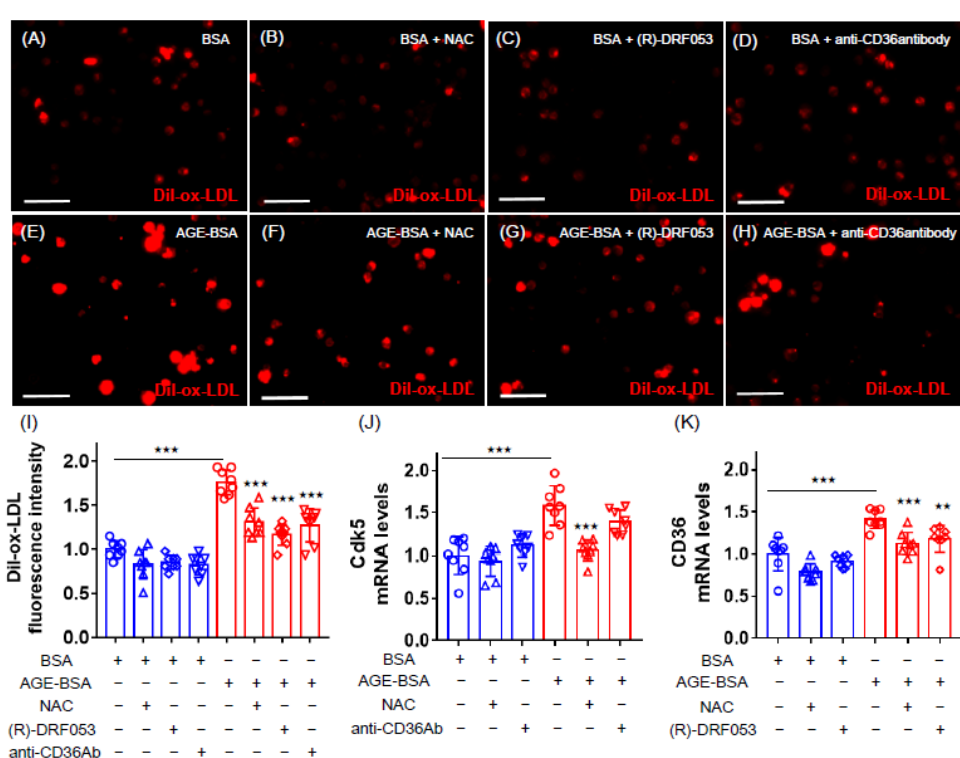
Figure 2. E ff ects of N -acetyl- l -cysteine (NAC), (R)-DRF053 dihydrochloride, and anti-CD36 antibody on Dil-ox-LDL uptake, Cdk5 and CD36 gene expression in AGE-exposed U937 cells. U937 macrophages were treated with 100 µ g / mL AGE-BSA or 100 µ g / mL nonglycated BSA in the presence or absence of 1 mmol / L antioxidant NAC, 0.215 µ mol / L selective inhibitor of Cdk5 (R)-DRF053 dihydrochloride, or 10 µ g / mL anti-CD36 antibody in RPMI 1640 medium supplemented with 10% fetal bovine serum including 100 ug / mL streptomycin and 100 U / mL penicillin at 37 ◦ C in 5% CO 2 for 24 h. The cells then were incubated with 10 µ g / mL Dil-ox-LDL in the same RPMI 1640 medium for 18 h to evaluate the fluorescence intensity. ( A – H ) Representative immunofluorescent staining images. Dil-ox-LDL-positive cells were stained in red. Scale bars represent 50 µ m. ( I ) Quantitative data of fluorescence intensity. Dil-ox-LDL uptake was normalized by the control values with BSA. ( J , K ) Gene expression levels of Cdk5 ( J ) and CD36 ( K ). Total RNAs were transcribed and amplified by real-time PCR. Data were normalized by the intensity of GAPDH mRNA-derived signals and then related to thecontrol valueswith BSA. Number = 8 for each group. Results are presented as mean ± standard deviation. (cid:70)(cid:70)(cid:70) p < 0.005, (cid:70)(cid:70) p < 0.01 vs. treatment of